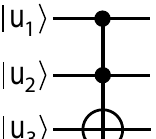
〉 and | u 〉 are the combined 1 2